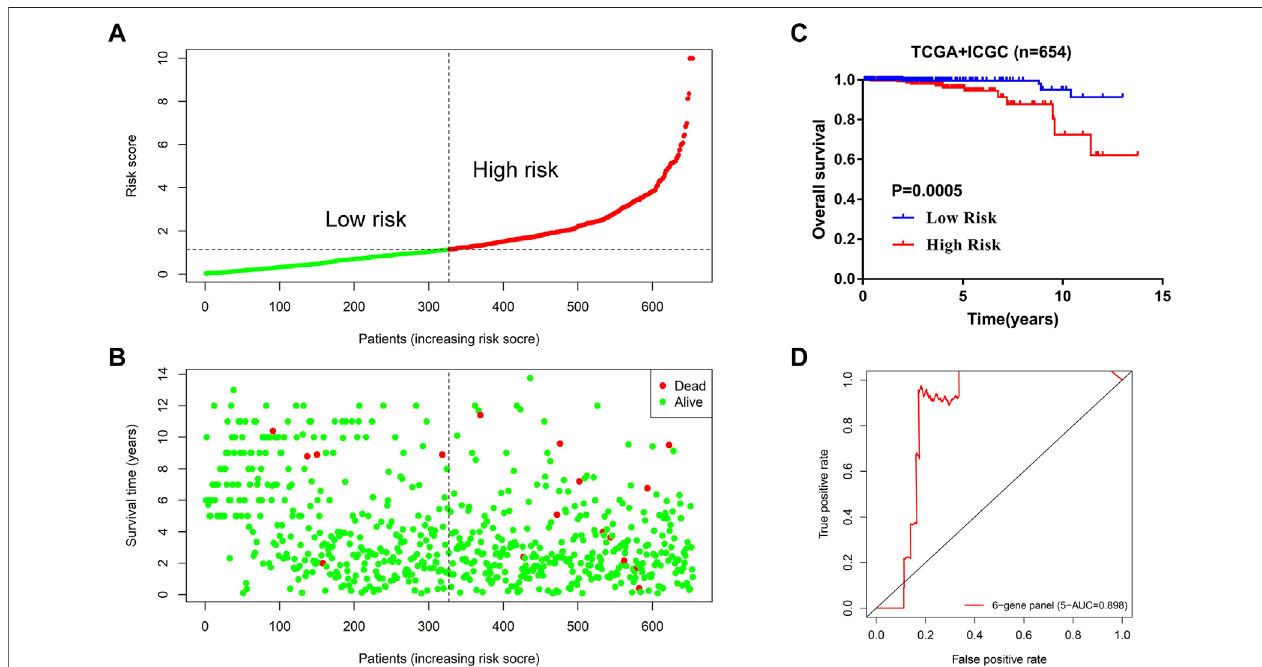
FIGURE 9 | Application potential of the 6-gene panel scoring model in large-scale PCa cohort diagnosis. (A,B) The distribution of risk score and survival status of PCa patients in the whole TCGA and ICGC cohorts (N = 654). (C) Kaplan – Meier analysis ofPCa patients for high-risk (red) and low-risk groups (blue). (D) The predictive ef fi ciency of the 6-gene panel scoring model was assessed by using a 5-year ROC curve.